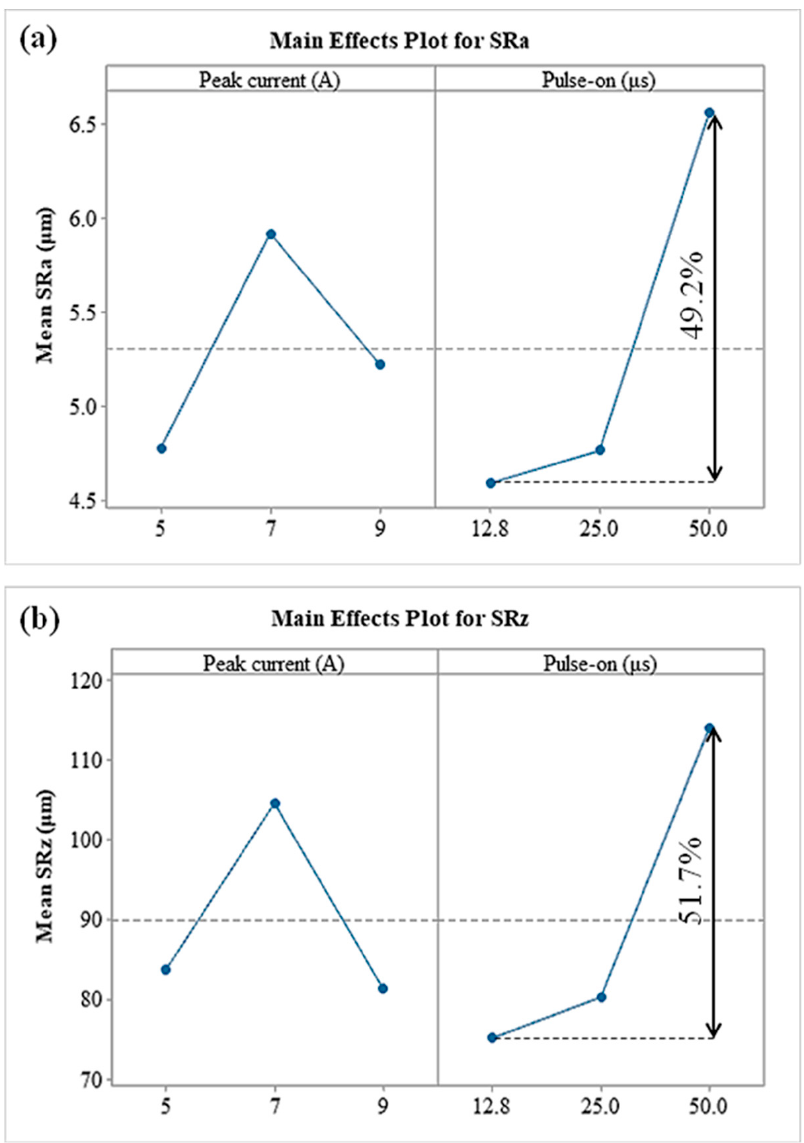
Figure 10. Main effect plot ( a ) for Ra, and ( b ) for Rz. Analysis of variance (ANOVA) was conducted to find the significance of each parame- ter, and the results for SRa and SRz are shown in Table 6. It is observed that pulse-on time does significantly influence SRa and SRz ( p <